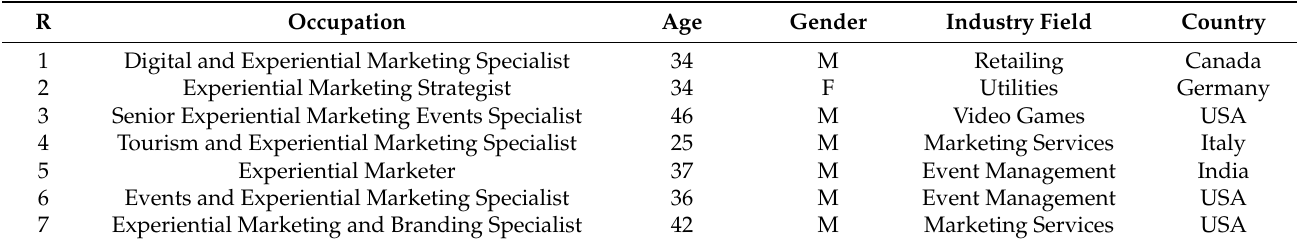
Table A1. Experts of Qualitative